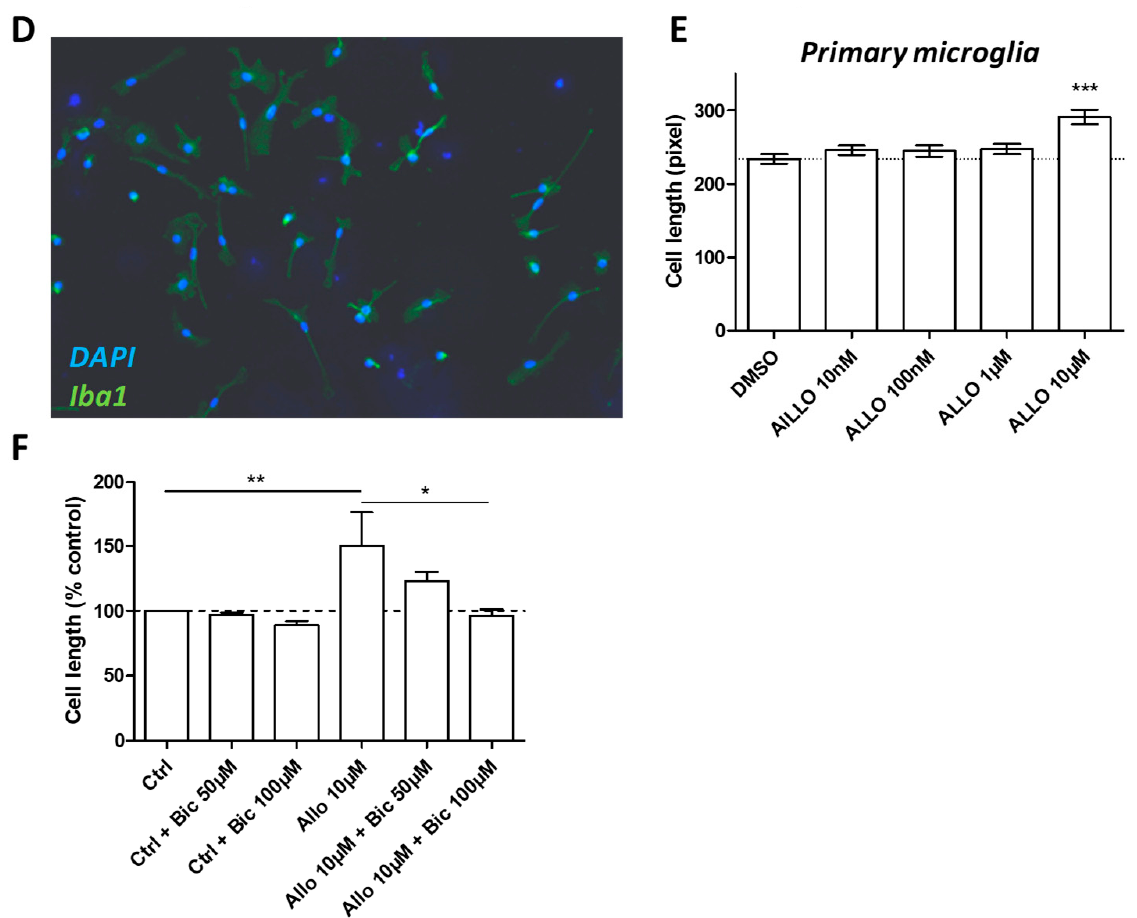
Figure 4. ALLO increases the length of microglial cells. ( A ) BV-2 cells grown in 1% FCS exhibited processes in both control and ALLO conditions. Scale bar = 50 µ M. ( B ) The proportion of bipolar vs. multipolar BV-2 cells (i.e., cells with more than two processes) was not modified after a treatment with ALLO. Mean values ± SEM are shown, with n = 188, control cells; n = 141, 10 nM ALLO-treated cells; n = 164, 100 nM ALLO-treated cells; n = 172, 1 µ M ALLO-treated cells; and n = 154, 10 µ M ALLO-treated cells; from n = four independent experiments. ( C ) The mean length of the primary processes carried by BV-2 was increased after a treatment with ALLO (10 µ M). Mean values ± SEM are shown, with n = 136, control cells; n = 105, 10 nM ALLO-treated cells; n = 97, 100 nM ALLO-treated cells; n = 106, 1 µ M ALLO-treated cells; and n = 113, 10 µ M ALLO-treated cells; from n = 4 independent experiments, *** p < 0.001. ( D ) Primary microglial cells that were grown in 1% FCS exhibited processes that had an increased length after incubation with ALLO (10 µ M). Scale bar = 50 µ M. ( E ) The mean length of primary microglial cells was increased after a treatment with ALLO (10 µ M). Mean values ± SEM are shown, with n = 291, control cells; n = 391, 10 nM ALLO-treated cells; n = 289, 100 nM ALLO-treated cells; n = 306, 1 µ M ALLO-treated cells; and, n = 274, 10 µ M ALLO-treated cells; from five independent experiments, *** p < 0.001. ( F ) The effect of ALLO on BV-2 cell morphology is mediated by the GABA-A receptor. The application of bicuculline (Bic) before the treatment with ALLO (10 µ M) abolished the ALLO-induced elongation of the processes carried by bipolar BV-2 cells. Mean values ± SEM are shown, from n = four independent experiments, * p < 0.05, ** p <